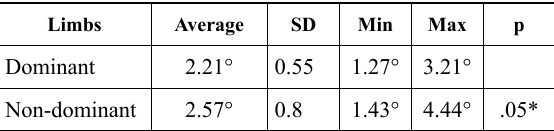
Table 2. Total Stability Index values in the dynamic balance test